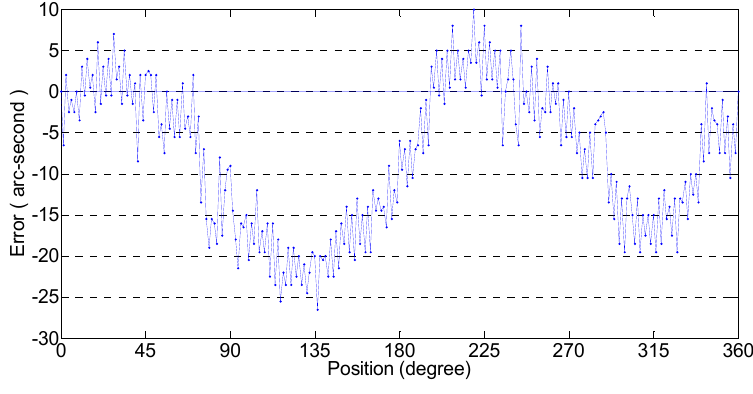
Figure 8. Encoder long-period error.